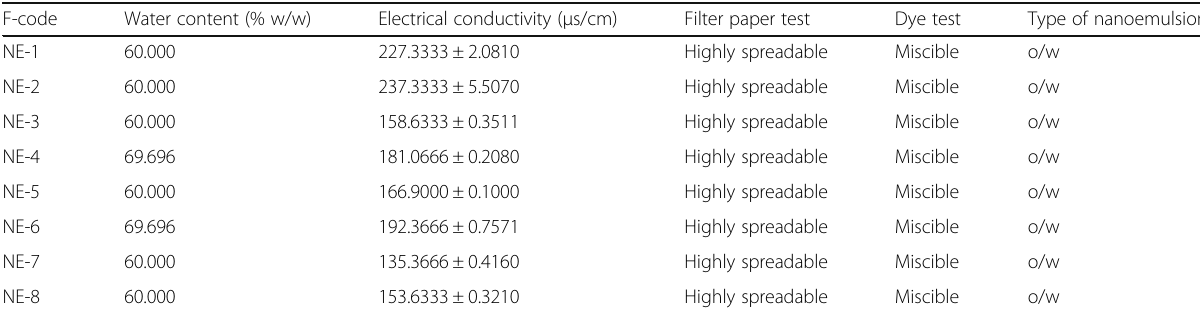
Table 5 Electroconductivity, filter paper test and dye test results of candesartan cilexetil nanoemulsions